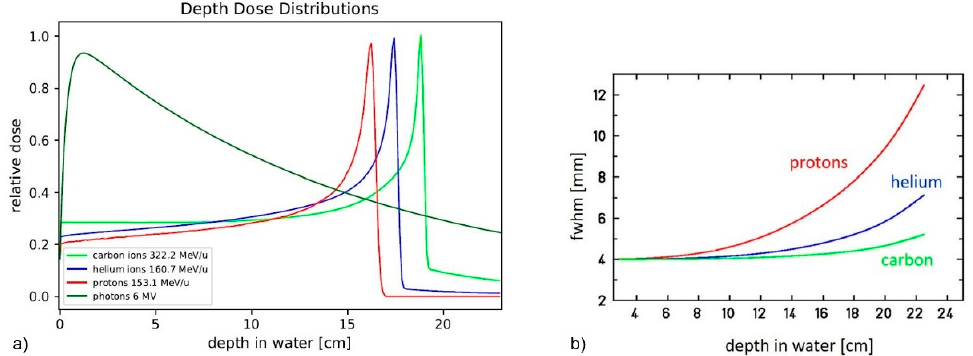
Figure 1. Physical properties of helium ions compared to photons and other ions. ( a ) relative absorbed dose of photons, protons, helium and carbon ions as a function of penetration depth. Bragg peak of helium ions is a sharper compared to protons. Fragmentation tail is smaller than for carbon ions. ( b ) full width half maximum of beams of protons, helium and carbon ions as a function of depth in water. Helium ions show less lateral scattering compared to protons (image: courtesy of U. Weber,